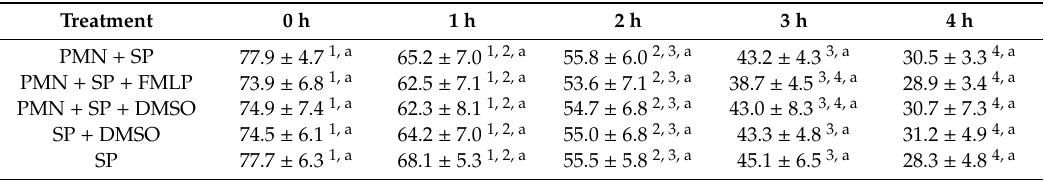
Table 2. Sperm viability in di ff erent treatments and after incubation at 37 ◦ C for 4 h (Experiment 2). Sperm concentration was set at 500 × 10 6 sperm / mL in all